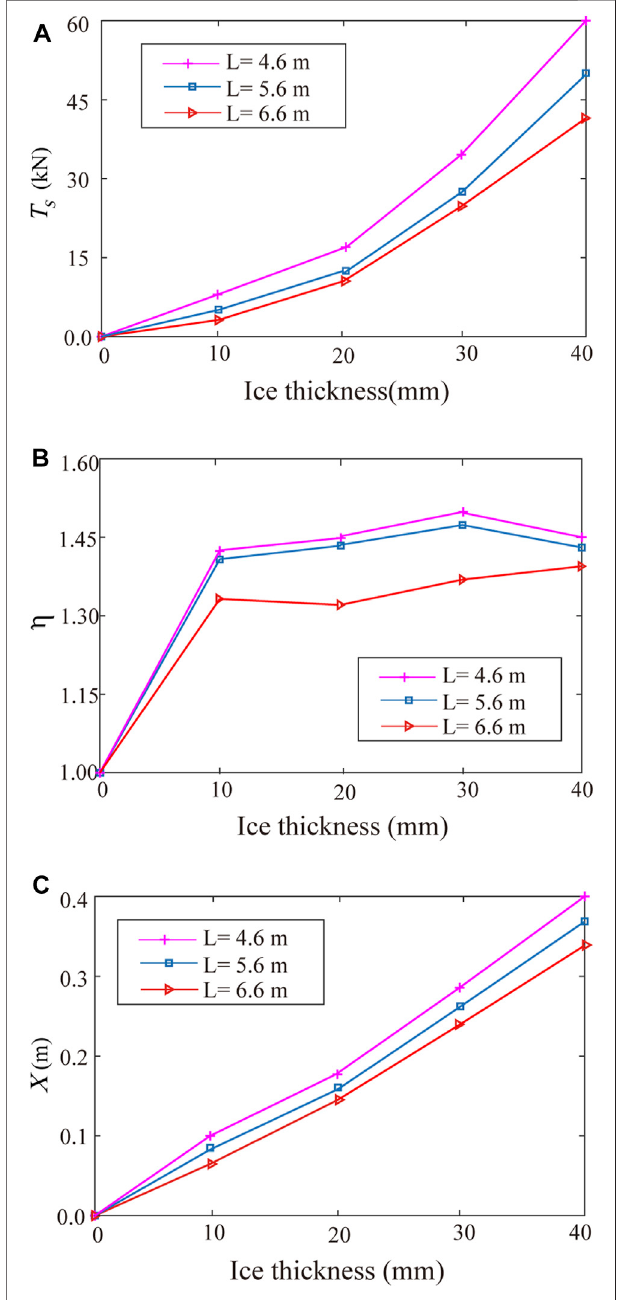
FIGURE7| Variations in theresponsesofthetower-line systemwith the differentinsulatorlengths (A) staticlongitudinalunbalancedtension (B) impact coef fi cient of the unbalanced tension (C) displacement of Point